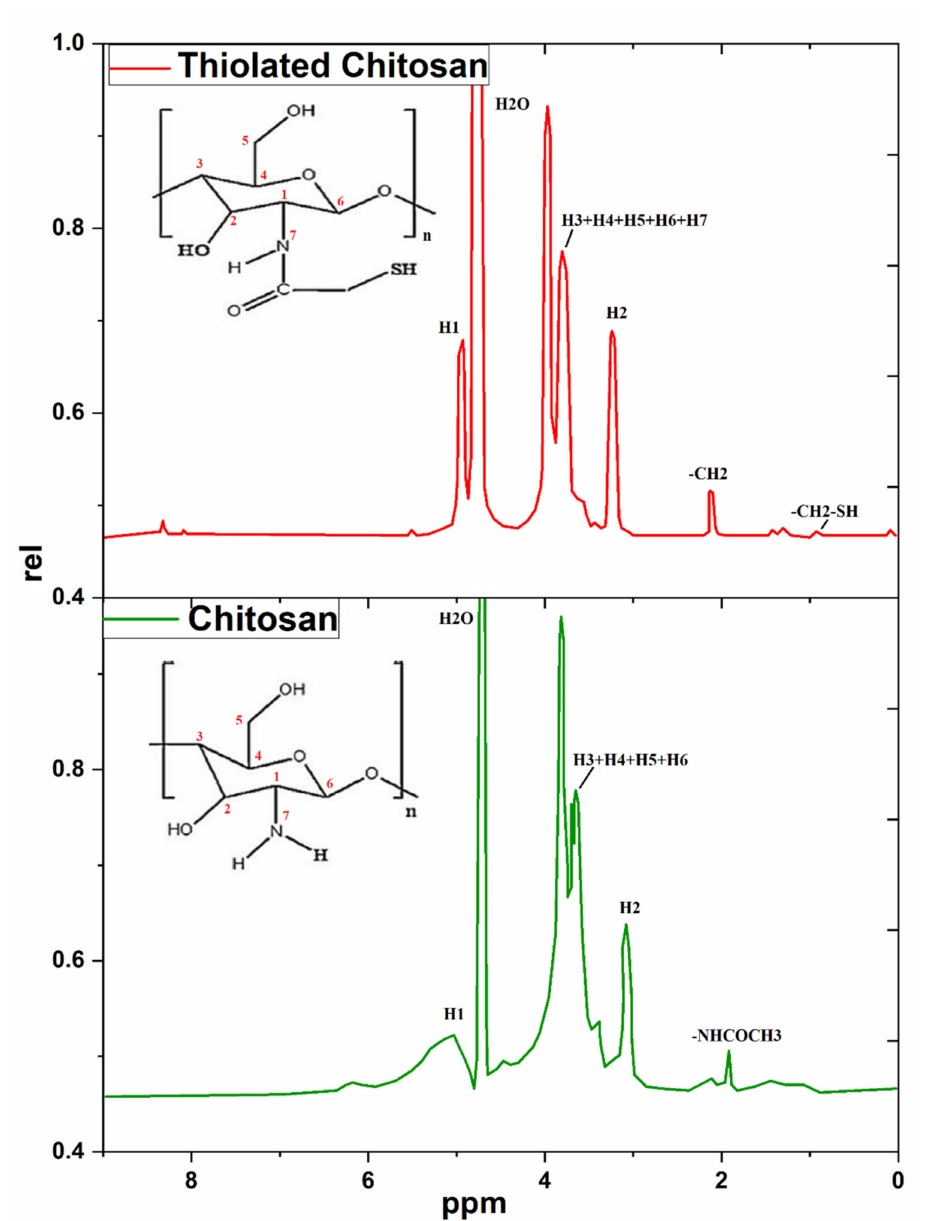
Figure 2. Nuclear magnetic resonance ( 1 HNMR) spectra of chitosan and thiolated chitosan synthe- sized by covalent bond formation between thioglycolic acid and chitosan via EDAC